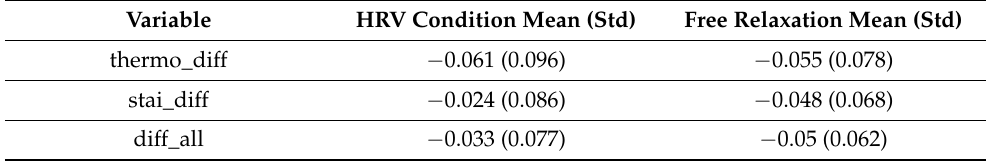
Table 2. Mean and standard deviation of the three variables on HRV and Free relaxation